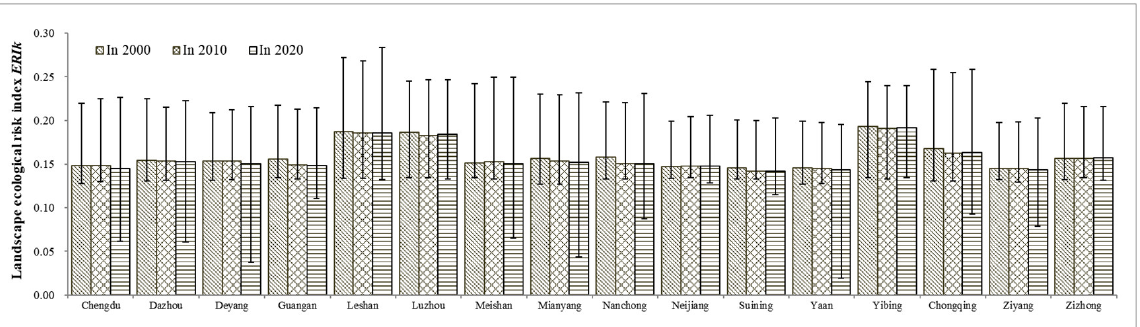
Figure 10. Statistical chart of the landscape ecological risk index values of 16 cities in 2000, 2010, and 2020.